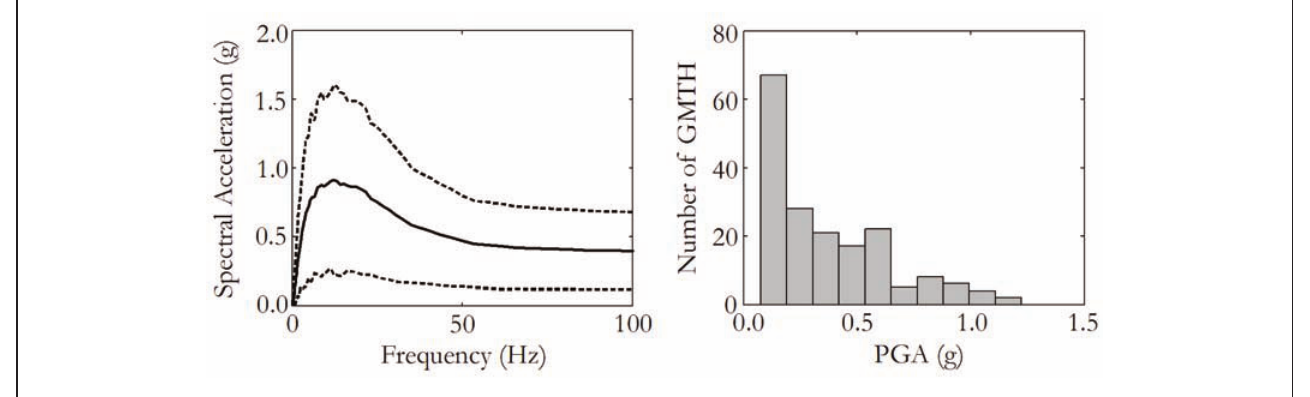
Figure 7 – Mean response spectrum and PGA distribution of the 180 synthetic ground motions